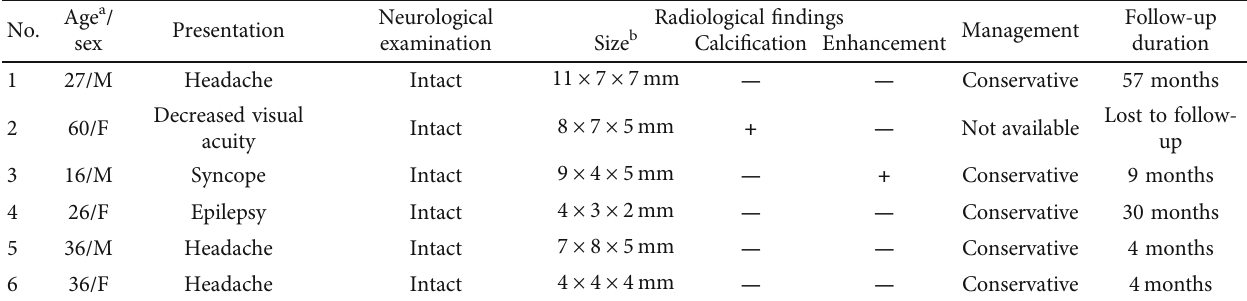
Table 1: Characteristics of patients with hypothalamic lipoma identi fi ed after radiological